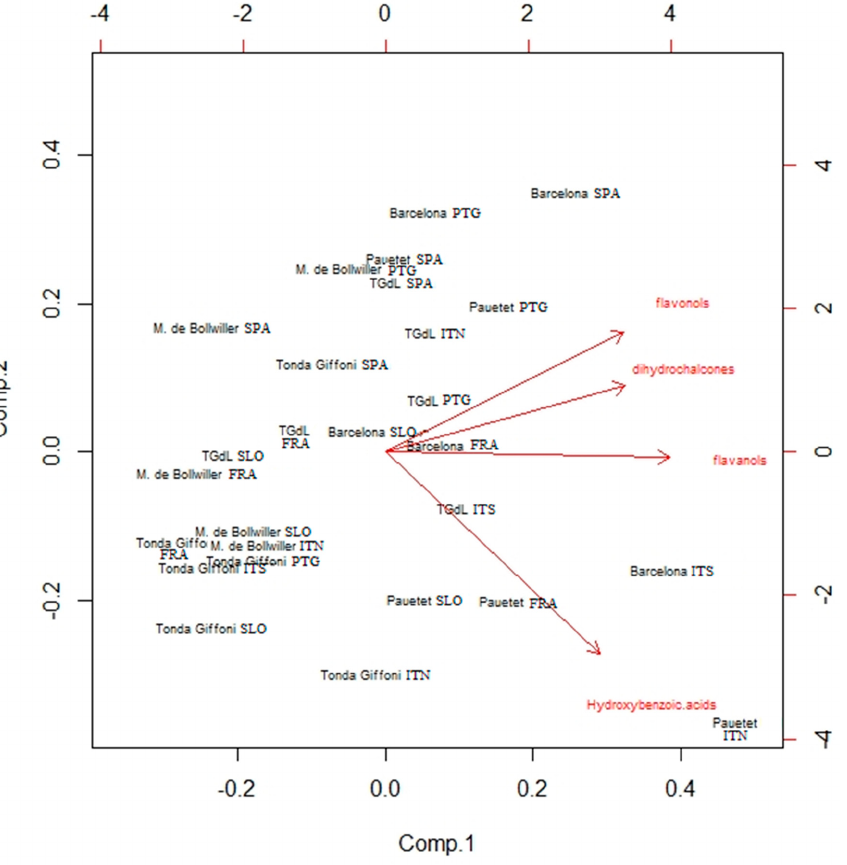
Figure 2. The PCA analysis of the content of four phenolic groups identified in different cultivars from six different regions of Europe.